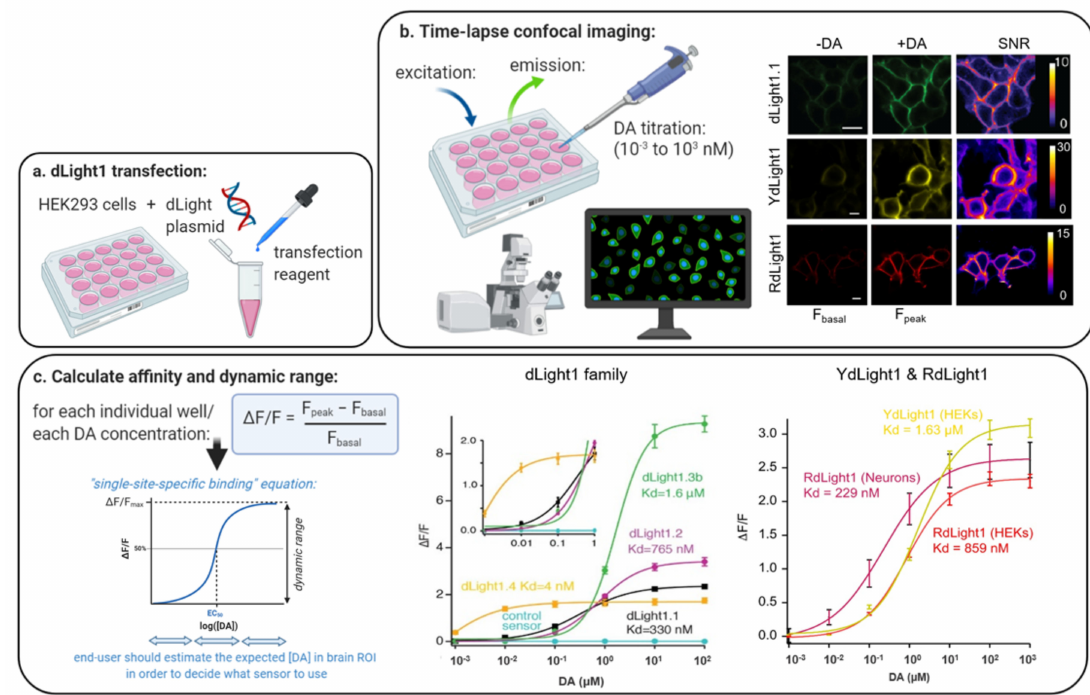
Figure 4. Concentration-response curves to determine a ffi nity (K d ) and dynamic range (dFF max )